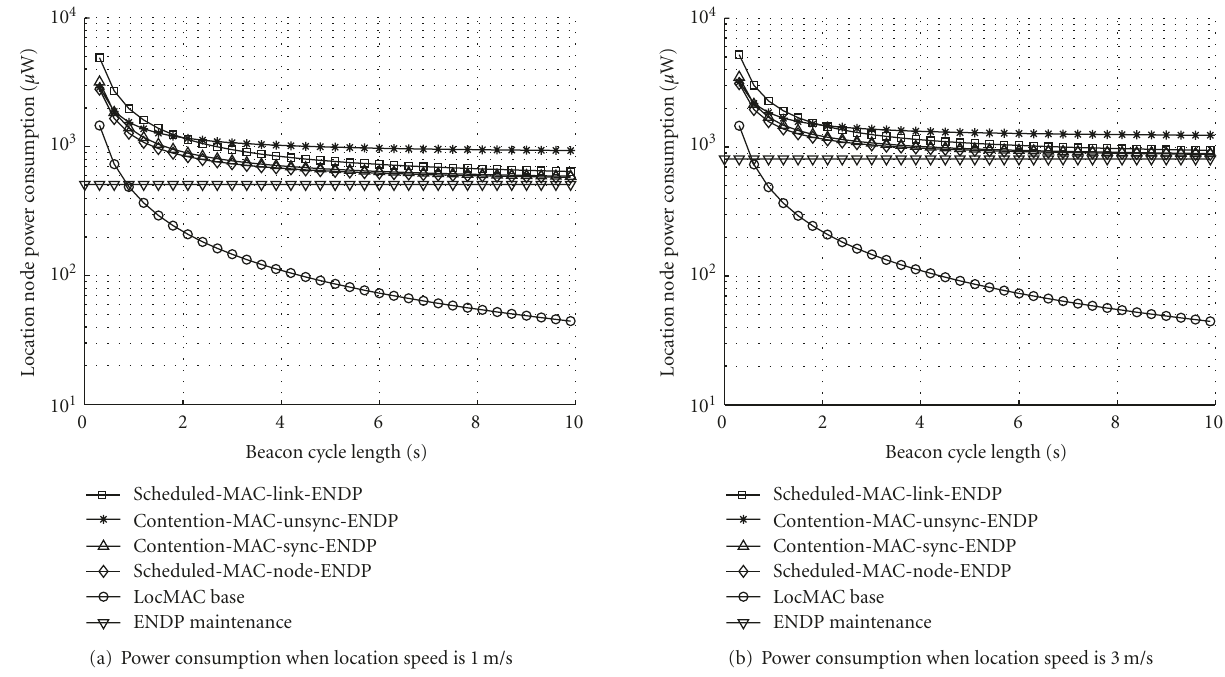
Figure 15: Power consumptions of scheduled-MAC-link, contention-MAC-unsync, contention-MAC-sync, scheduled-MAC-node, and LocMAC base as a function of beacon cycle length when location node is mobile and ENDP is used as the neighbor discovery method.